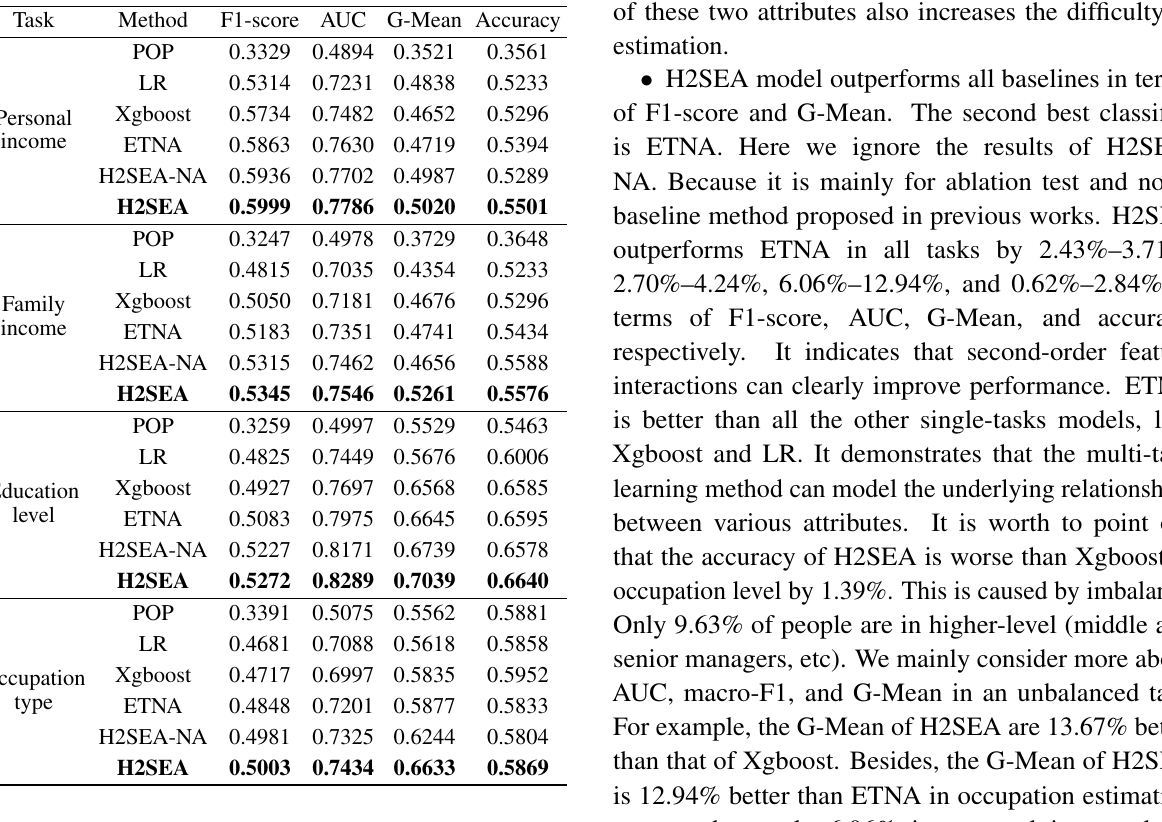
Table 3 Performance